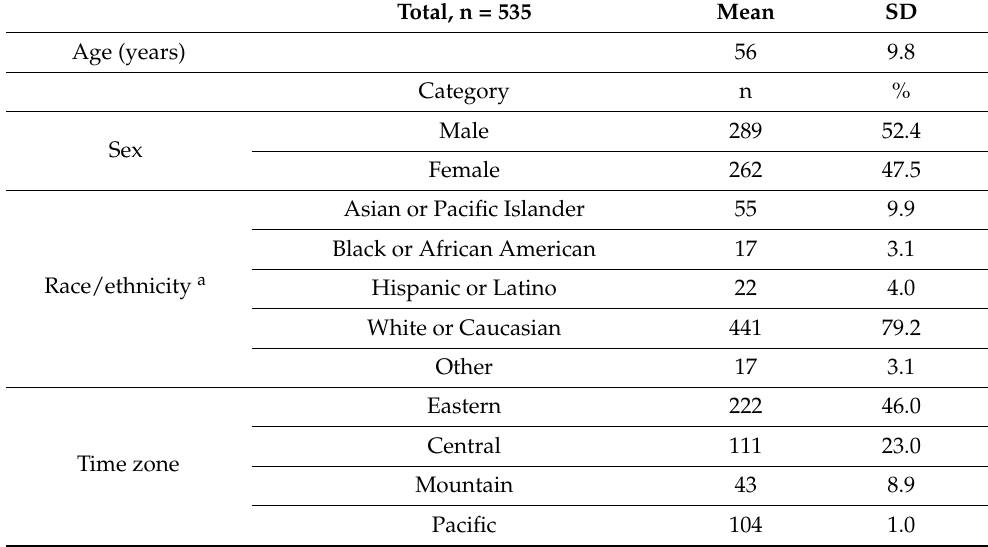
Table 2. Demographics and professional